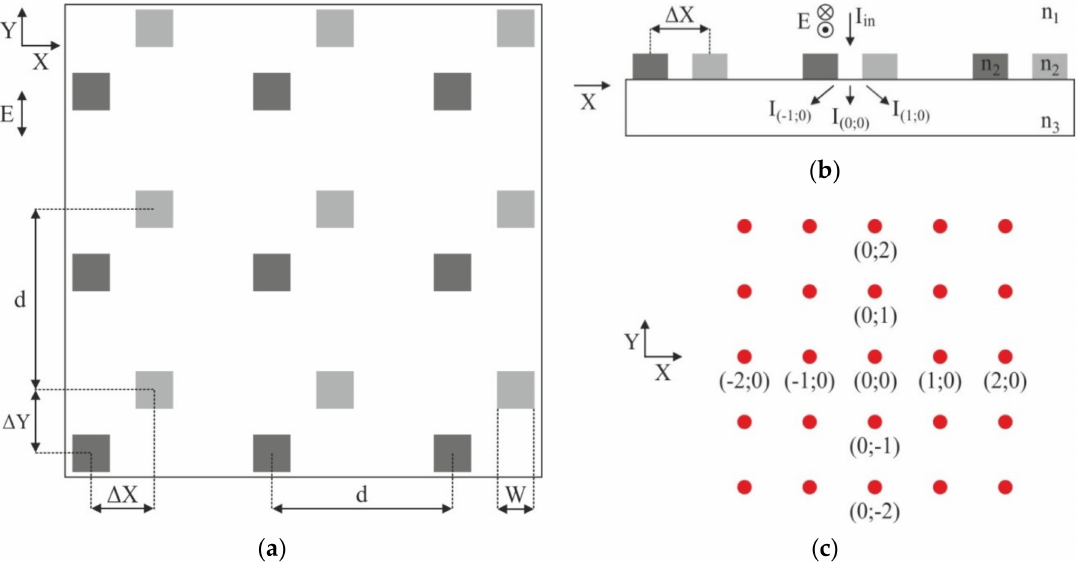
Figure 9. Geometry for 2D DSE modeling: layout of the gratings ( a ); sectional modeling geometry ( b ); diffraction orders notation ( c